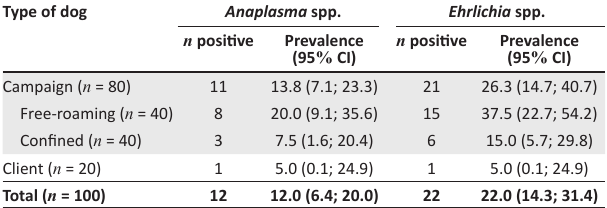
TABLE 2: Prevalence (with confidence intervals) of endoparasites in faeces from 40 campaign dogs in Lilongwe, Malawi, September–October 2014. Genus n positive Prevalence (95 % CI) Ancylostoma spp.